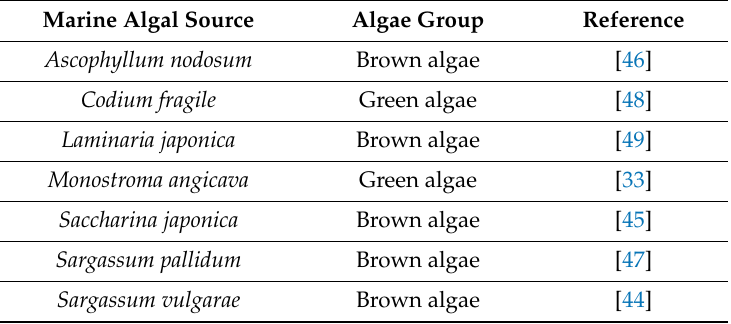
Table 5. Marine algae source with antidiabetic activity attributed to